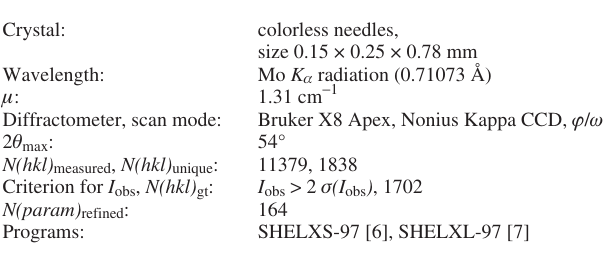
Table 1. Data collection and handling.